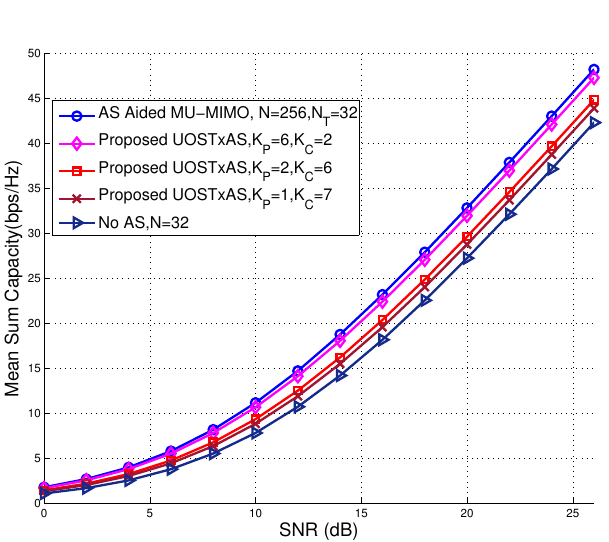
Figure 8. Achievable sum capacity performance comparison of proposed UOSTxAS associated with { K = 1, K = 7 } , { K = 2, K = 6 } and { K = 6, K = 2 } , AS aided MU-MIMO and conventional P P P C C C MU-MIMO without AS systems, associated with K = 8 active users, N = 256 antennas, N T = 32 transmit RF chains,